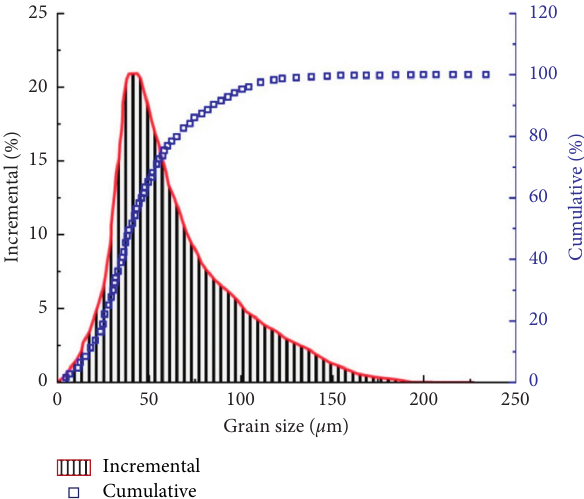
Figure 1: Grain size distribution of the tailings used.